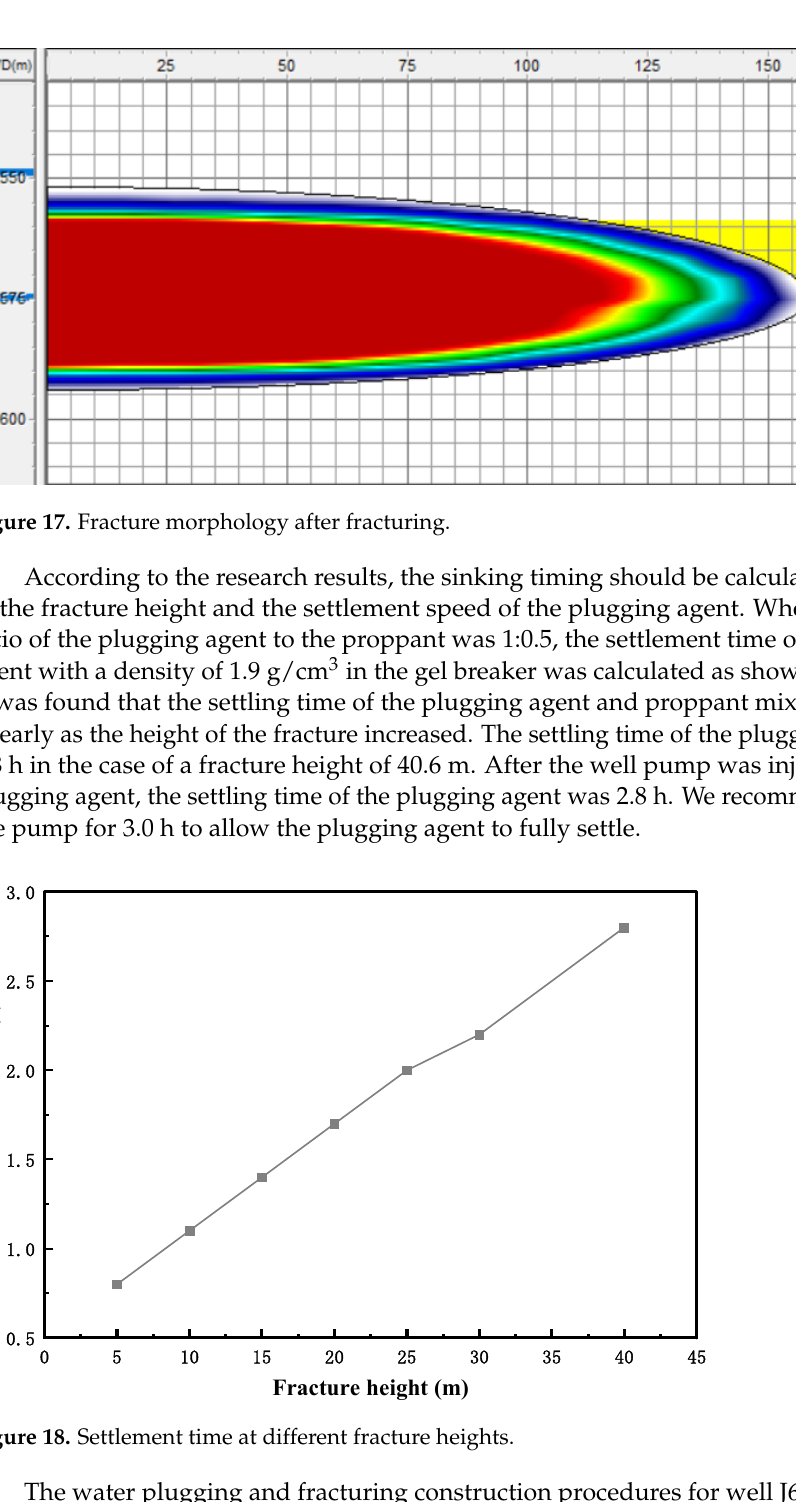
Table 10. Fracturing treatment pump injection procedure.